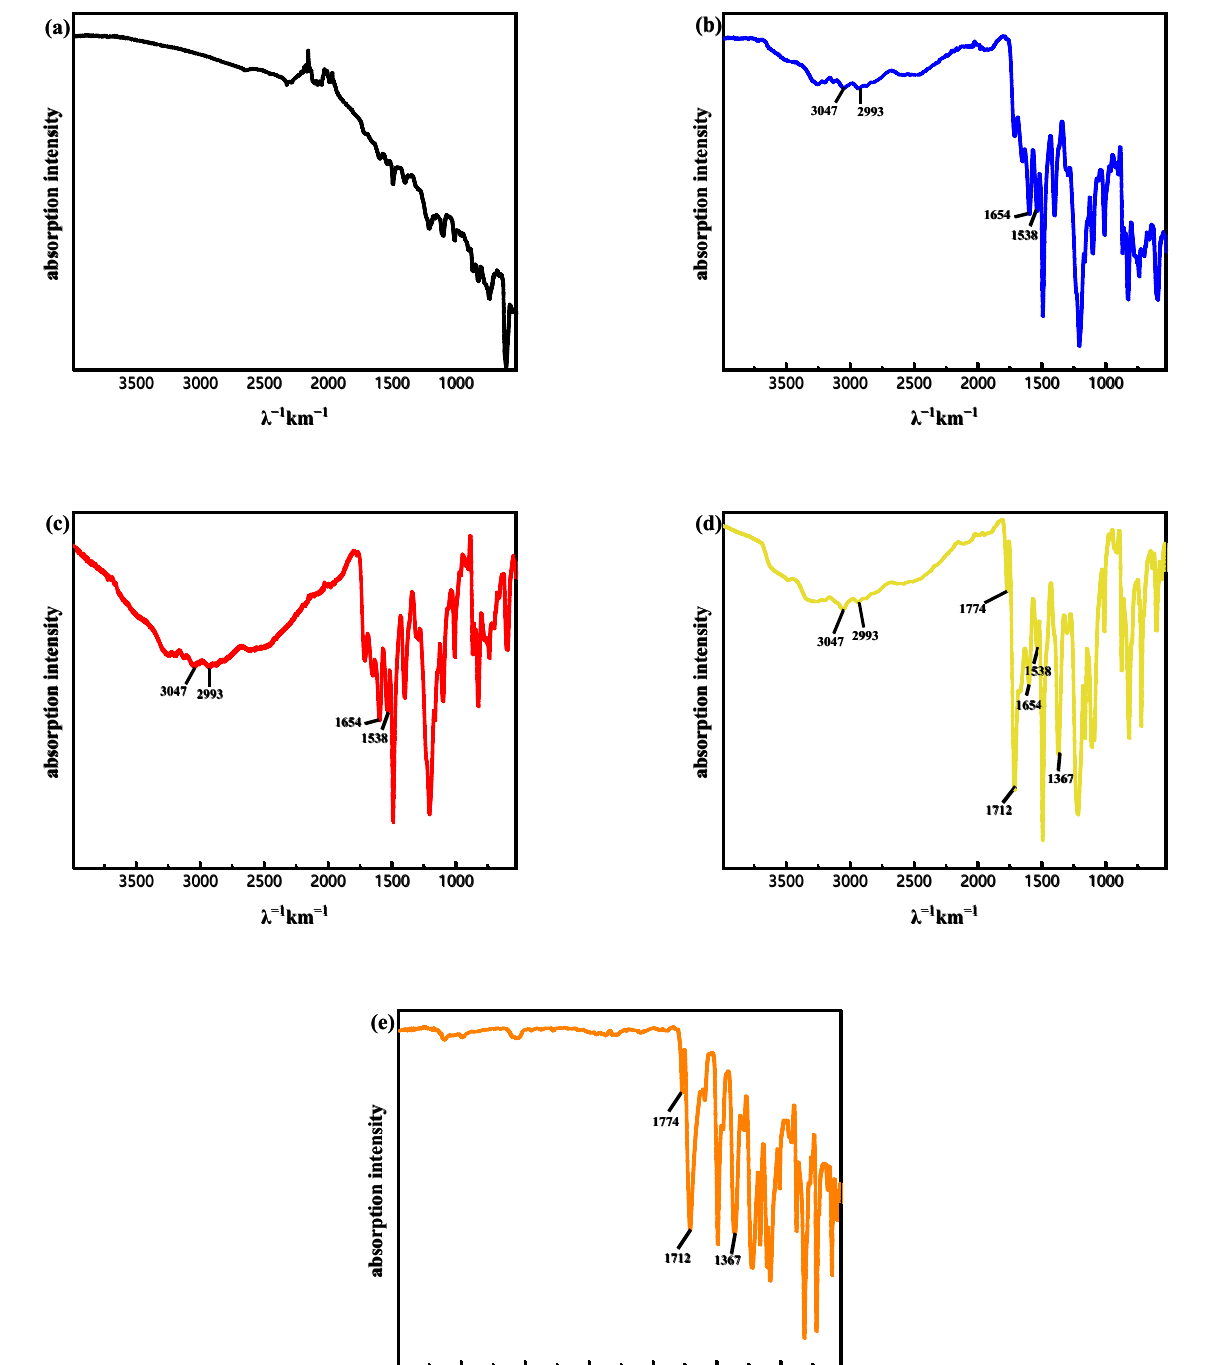
Figure 3. Fourier transform infrared (FT-IR) spectra of PI film after pre-baking at ( a ). 80 °C, 1 min; ( b ). 80 °C, 30 min; ( c ). 80 °C, 30 min; 150 °C, 30 min; ( d ). 80 °C, 30 min; 150 °C, 30 min, 250 °C, 30 min; ( e ). 80 °C, 30 min; 150 °C, 30 min; 250 °C, 2 h.